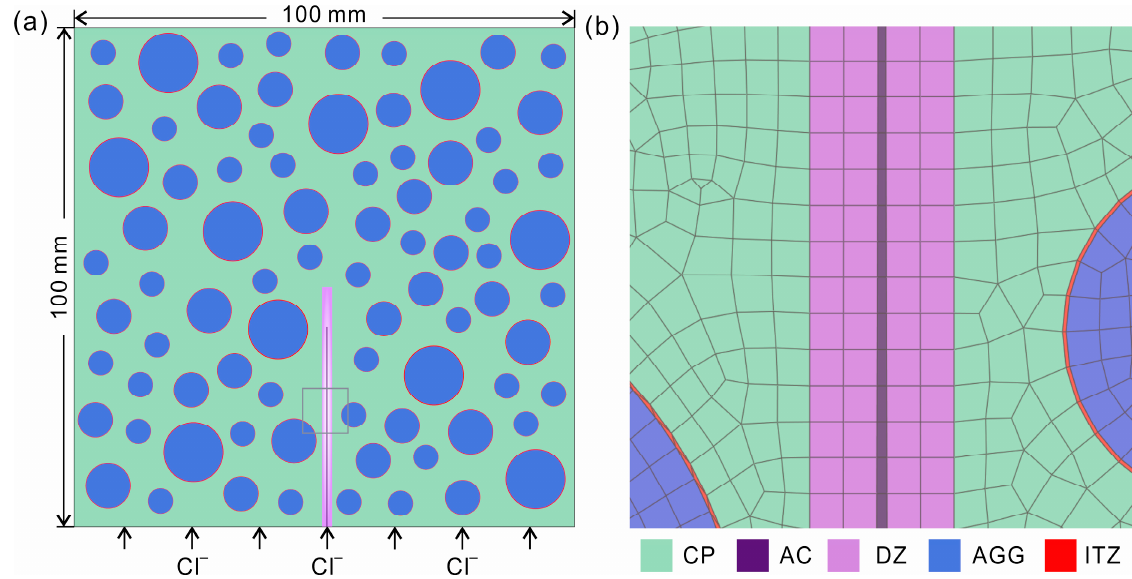
Figure 1. ( a ) Schematic diagram and ( b ) enlarged zone of the mesoscale model of concrete. Concrete consists of cement paste (CP), artificial cracks (ACs), a damage zone (DZ), aggregate (AGG) and an interface transition zone (ITZ). The mesh is a four-node linear heat transfer quadrilateral element sampled using the fi nite di ff erence method.